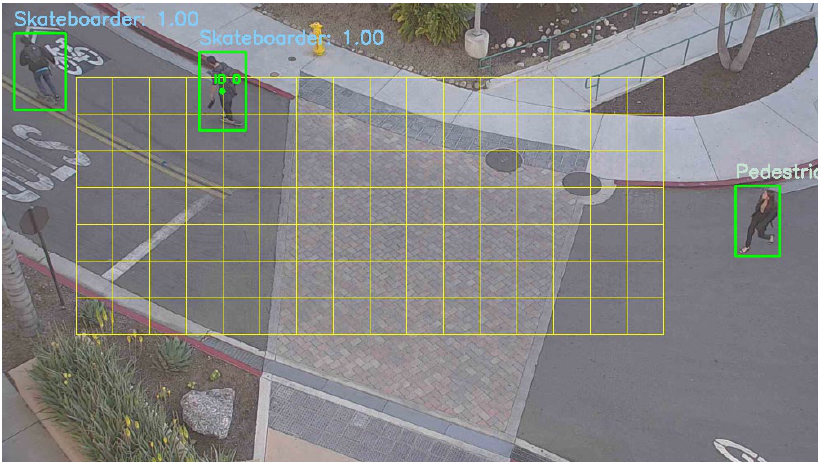
Figure 25. Skateboarder inside the grid has a registered ID. The skateboarder leaving the grid is de-registered. The pedestrian is yet to be registered, as she has not entered the grid area.